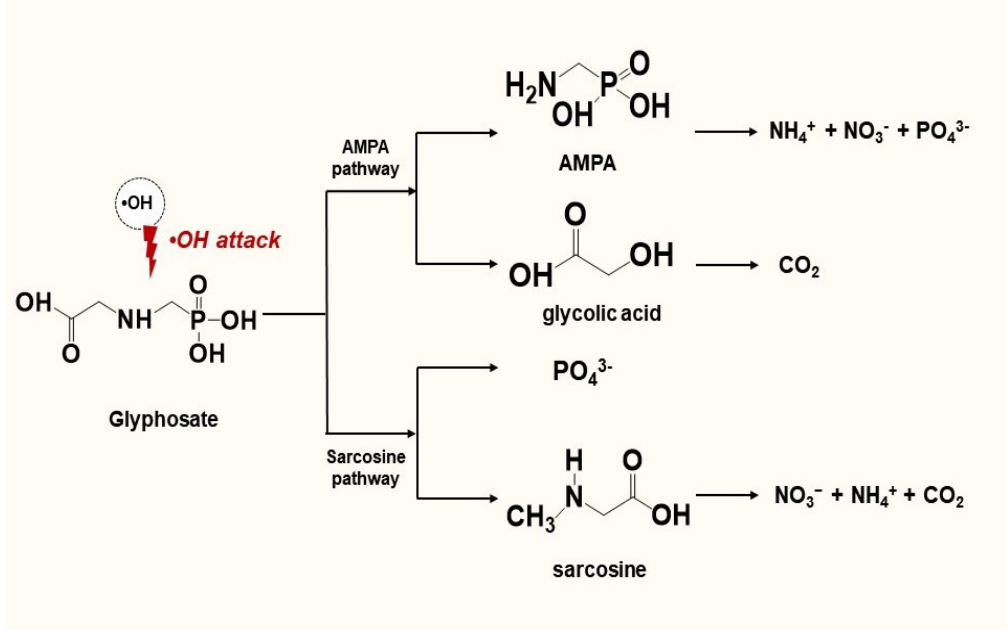
Figure 12. Proposed glyphosate degradation pathways via AOPs.